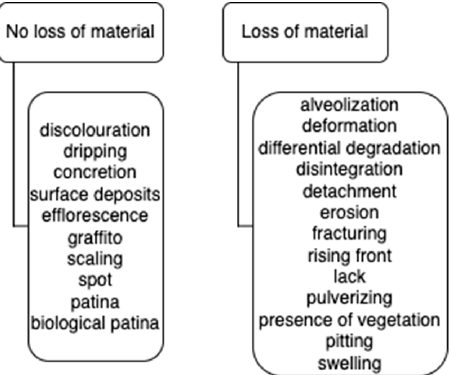
Figure 6. Degradation classification of stone and wood materials. take into account the danger of each degradation generating further degradation (Table 2). Table 2. Assessing the level of severity and value to degradation.